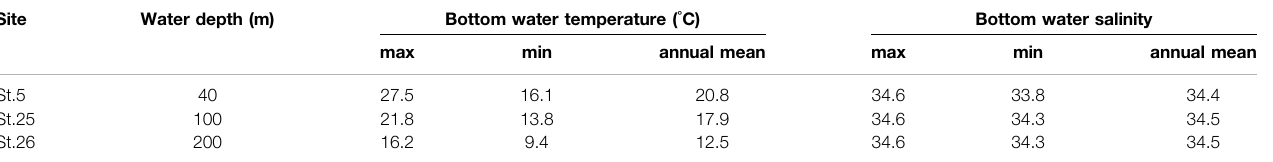
TABLE 3 | Seasonal maximum, minimum, and annual mean value of bottom water temperature and salinity from three sites in Tosa Bay.